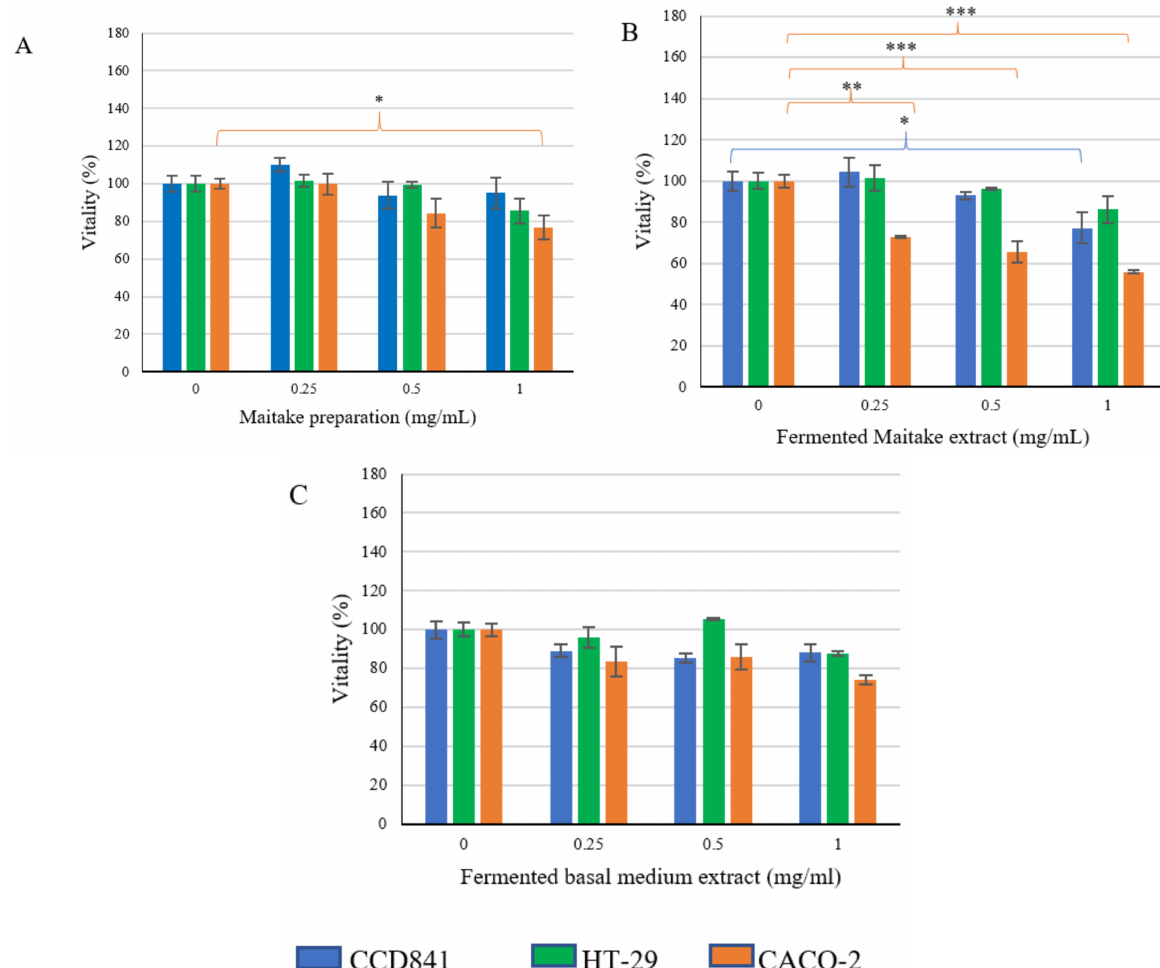
Figure 4. Differential effects of extracted secondary metabolites on cell viability. The figure represents the viability of the three different cell lines in presence of Maitake extract ( A ), fermented Maitake extract ( B ), and fermented control medium extract ( C ). Values are represented as mean value of vitality % ± standard error. Statistical differences were calculated using Dunnett’s multiple comparisons test: * p -value < 0.05, ** p -value < 0.01, *** p -value <